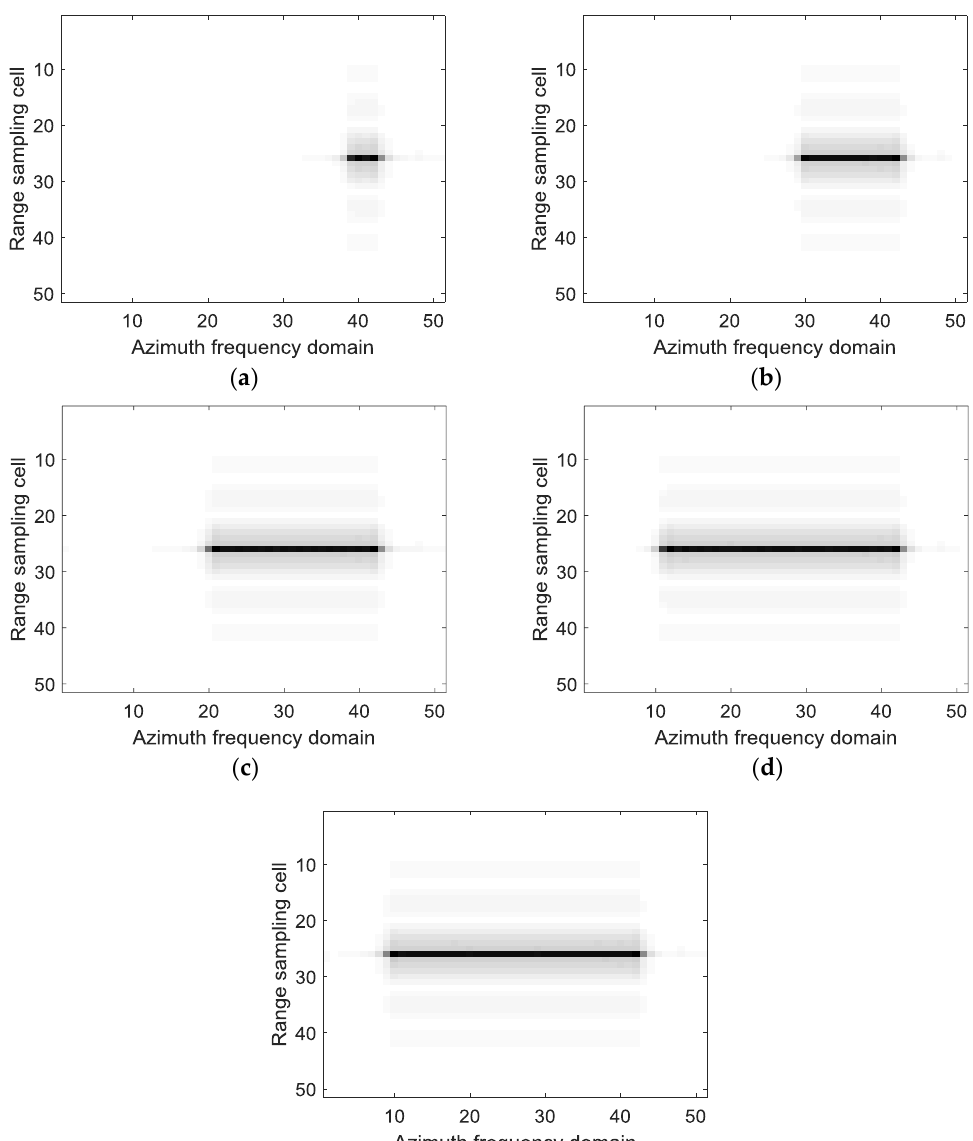
Figure 8. Frequency spectrum of the azimuth signal after sub-aperture synthesis. ( a ) With one sub-aperture datum; ( b ) With two sub-aperture data; ( c ) With three sub-aperture data; ( d ) With four sub-aperture data; ( e ) With five sub-aperture data.